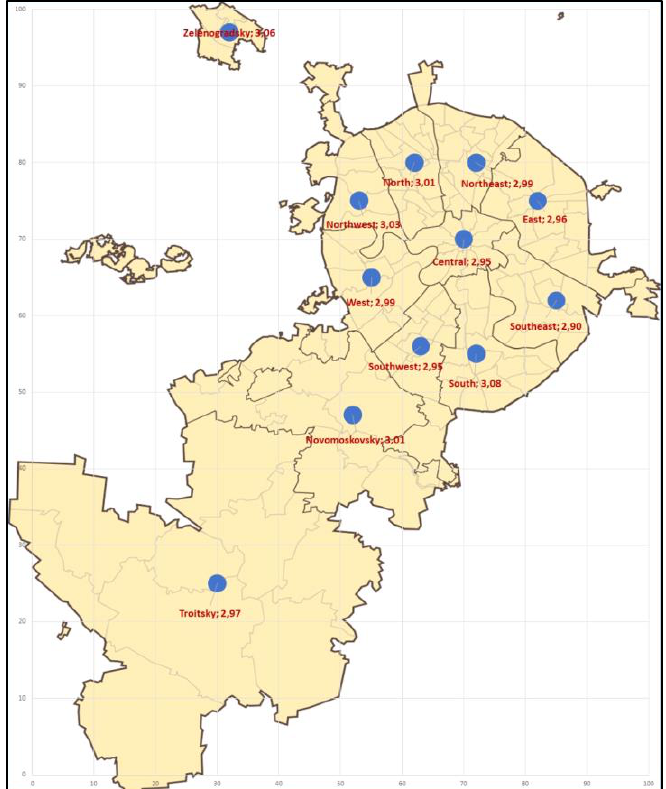
Figure 6. Relationship between the administrative district of Moscow of the respondent's residence and PAAverage PA (on a scale from 1 to 4).